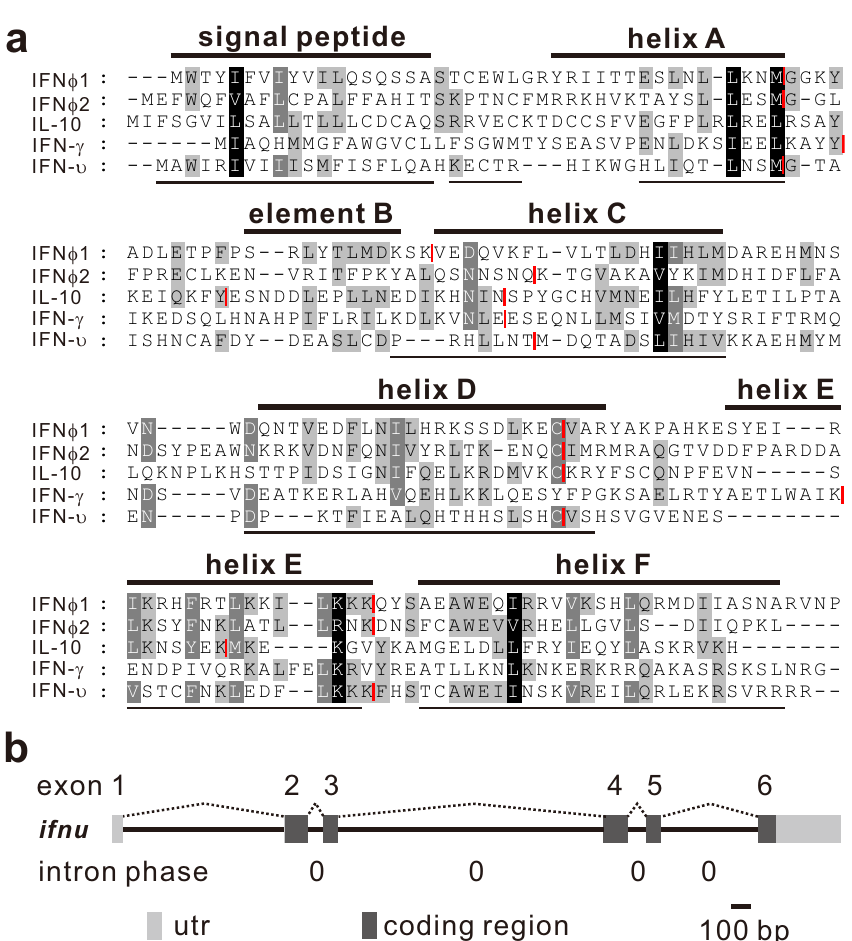
Fig. 1 Identi fi cation of zebra fi sh IFN- υ . a Sequence alignment of IFN- υ protein. Identical or similar amino acids are indicated in shade. The putative signal peptide and helices of IFN- υ are underlined and the known helices A to F for zebra fi sh IFN φ 1 are highlighted by solid lines above the alignment. Intron positions are indicated in red line. b The gene organization of zebra fi sh IFN- υ . Exons and introns are indicated with gray boxes and lines, respectively. The intron phases of ifnu are all zero. The utr indicates untranslated